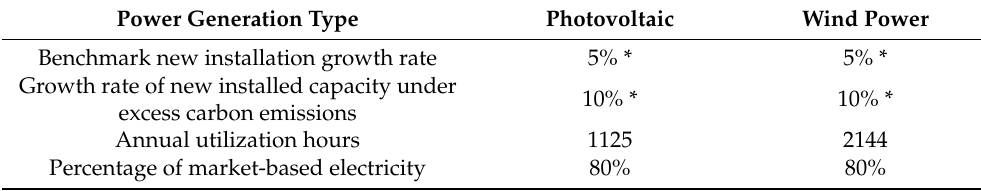
Table 3. Parameters setting of wind power and photovoltaic power generation in basic